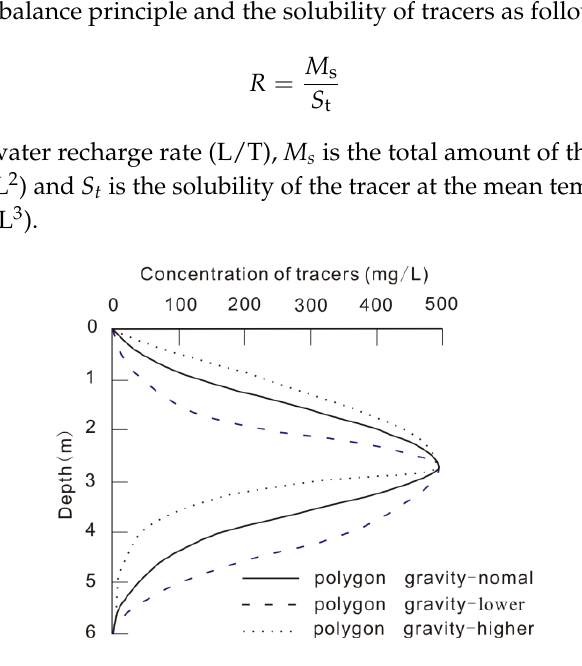
Figure 2. Different distributions of tracers in the soil profile with the same depth of peak.